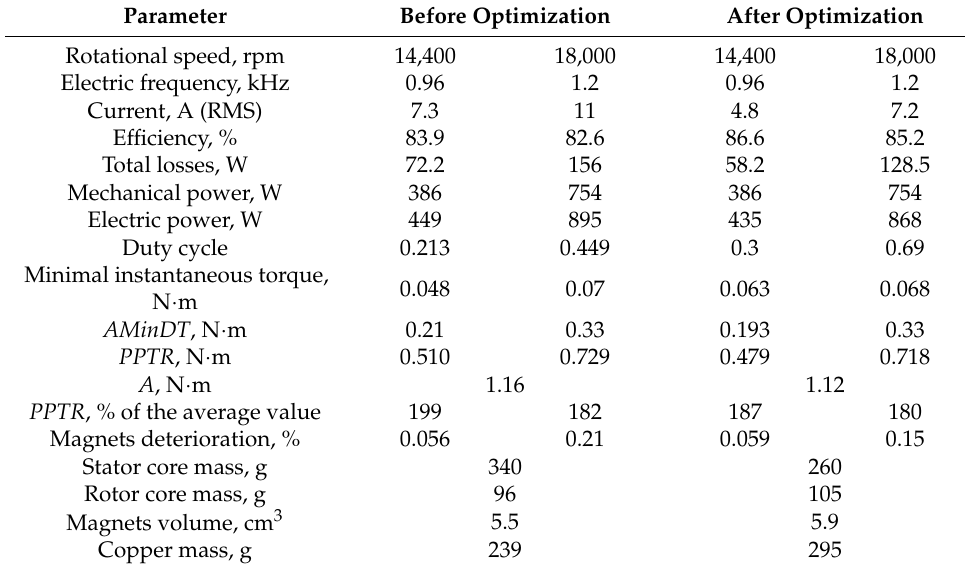
Table 4. The FRM characteristics before and after optimization.